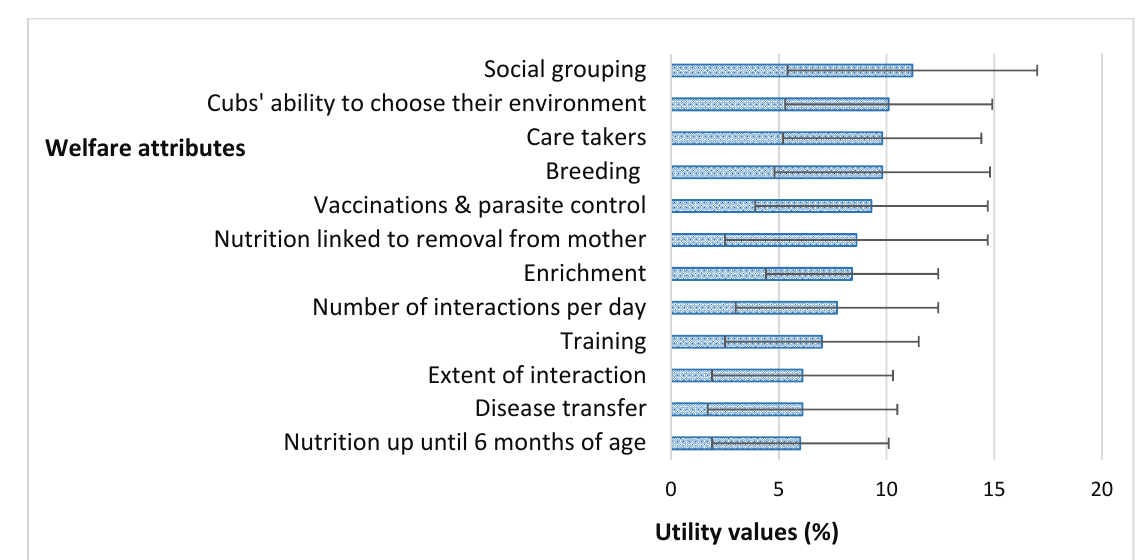
Figure 2. Utility values of the welfare attributes included in the online adaptive conjoint analysis survey, indicating their mean values and standard deviations.